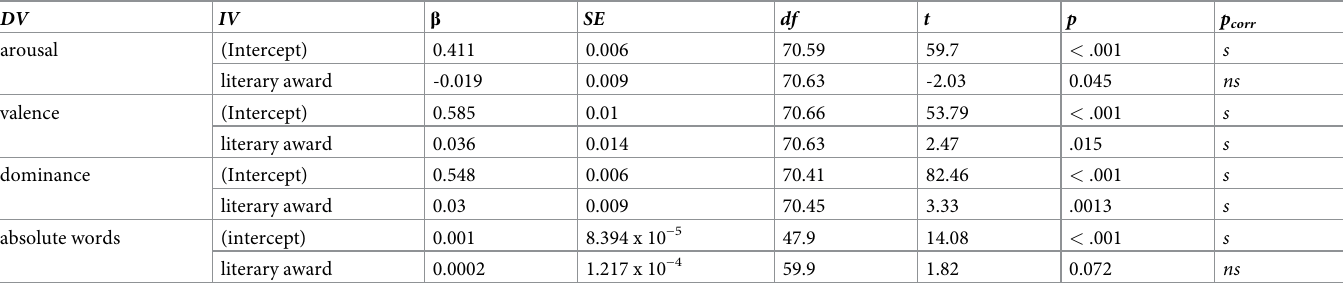
Slopes estimated with respect to book-related subreddit classification.